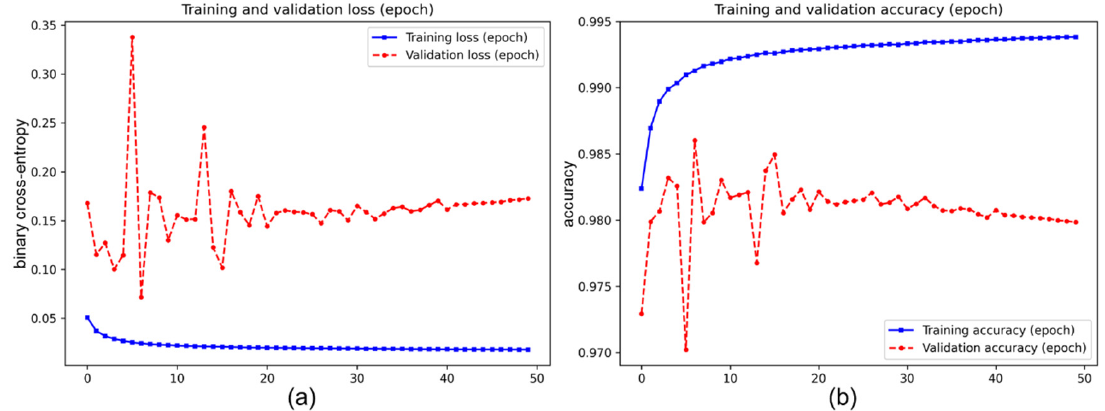
Figure A7. The loss and accuracy curves of Chiodini2020 [44] using the synthetic dataset. ( a ) Refers to the epoch-wised loss curves in the training and validation sets. ( b ) Refers to the epoch-wised accuracy curves in the training and validation sets.